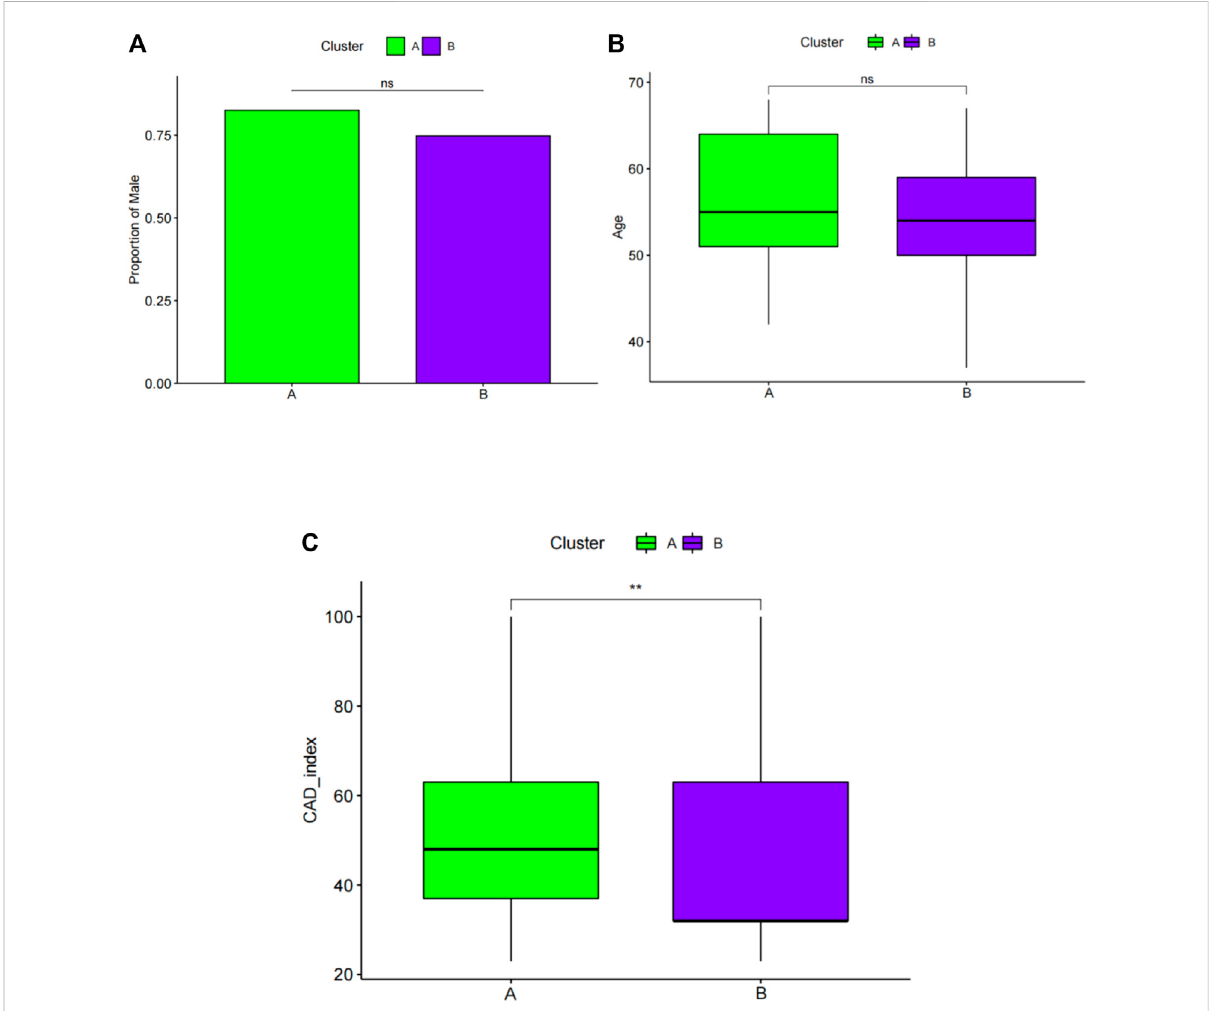
FIGURE 8 Pairwise comparisons of clinical characteristics between cluster A and cluster B. (A) The proportion of men in each subgroup is represented by the bar plot. Boxplots (B,C) display ages and CAD indices for subgroups. CAD: coronary artery disease. * p < 0.05, ** p < 0.01, and *** p < 0.001.